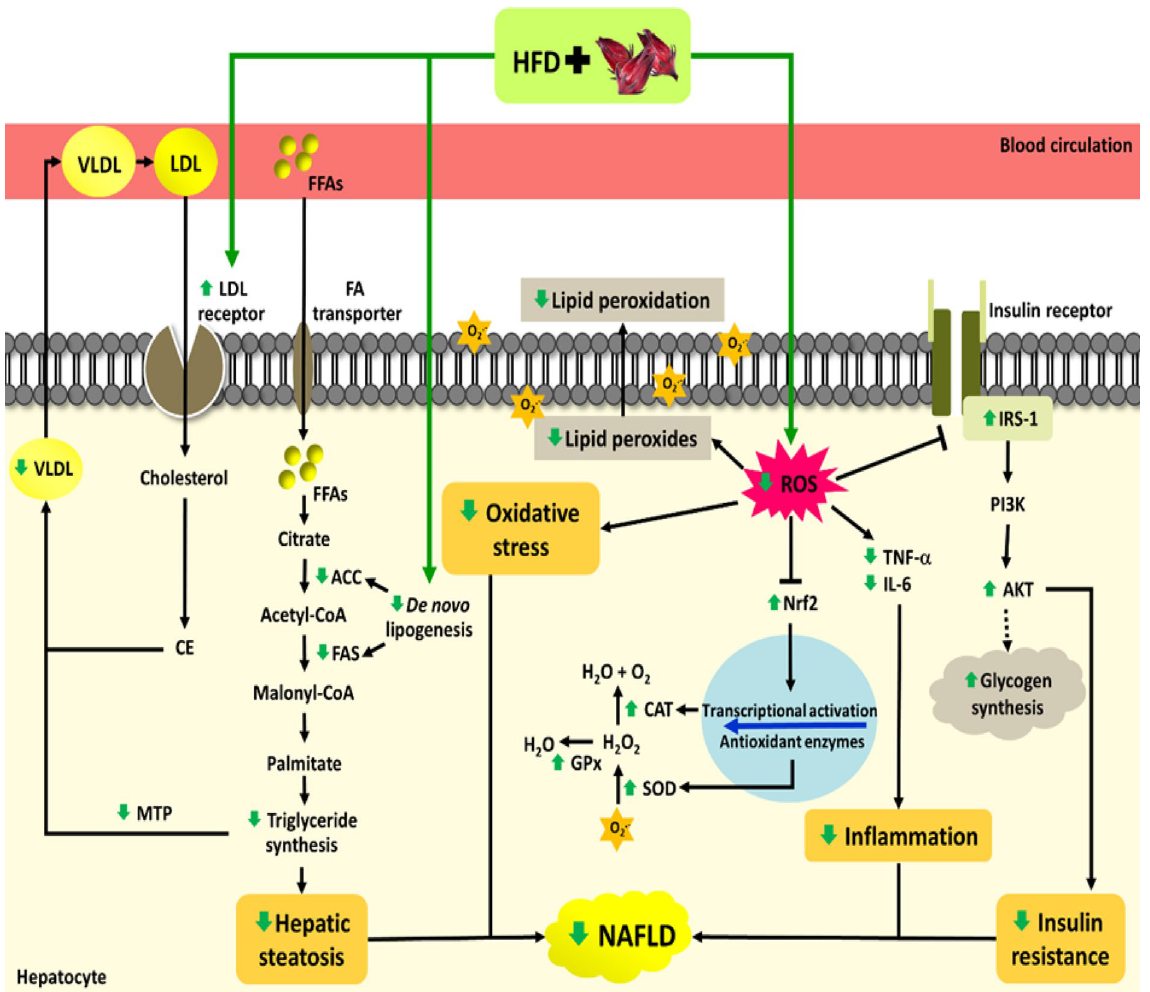
Figure 6. Schematic summary of the mechanism of action of roselle extract on NAFLD rats induced by high fat diet. Roselle extract inhibits hepatic steatosis via inhibiting de novo lipogenesis pathway leads to decreased lipid accumulation in the liver. Roselle extract prevents the increase of ROS and activates antioxidant protein regulators, against oxidative damage and inflammation in rats fed with a high fat diet. Roselle extract improves insulin resistance and promotes antioxidant properties by partial activating IRS-1/Akt and Nrf2 signal